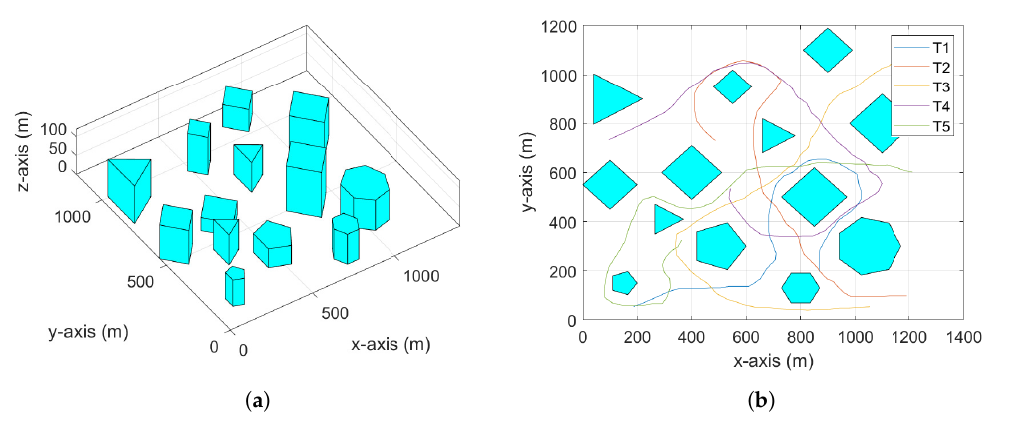
Figure 7. ( a ) The simulated urban environment. ( b ) The trajectories of